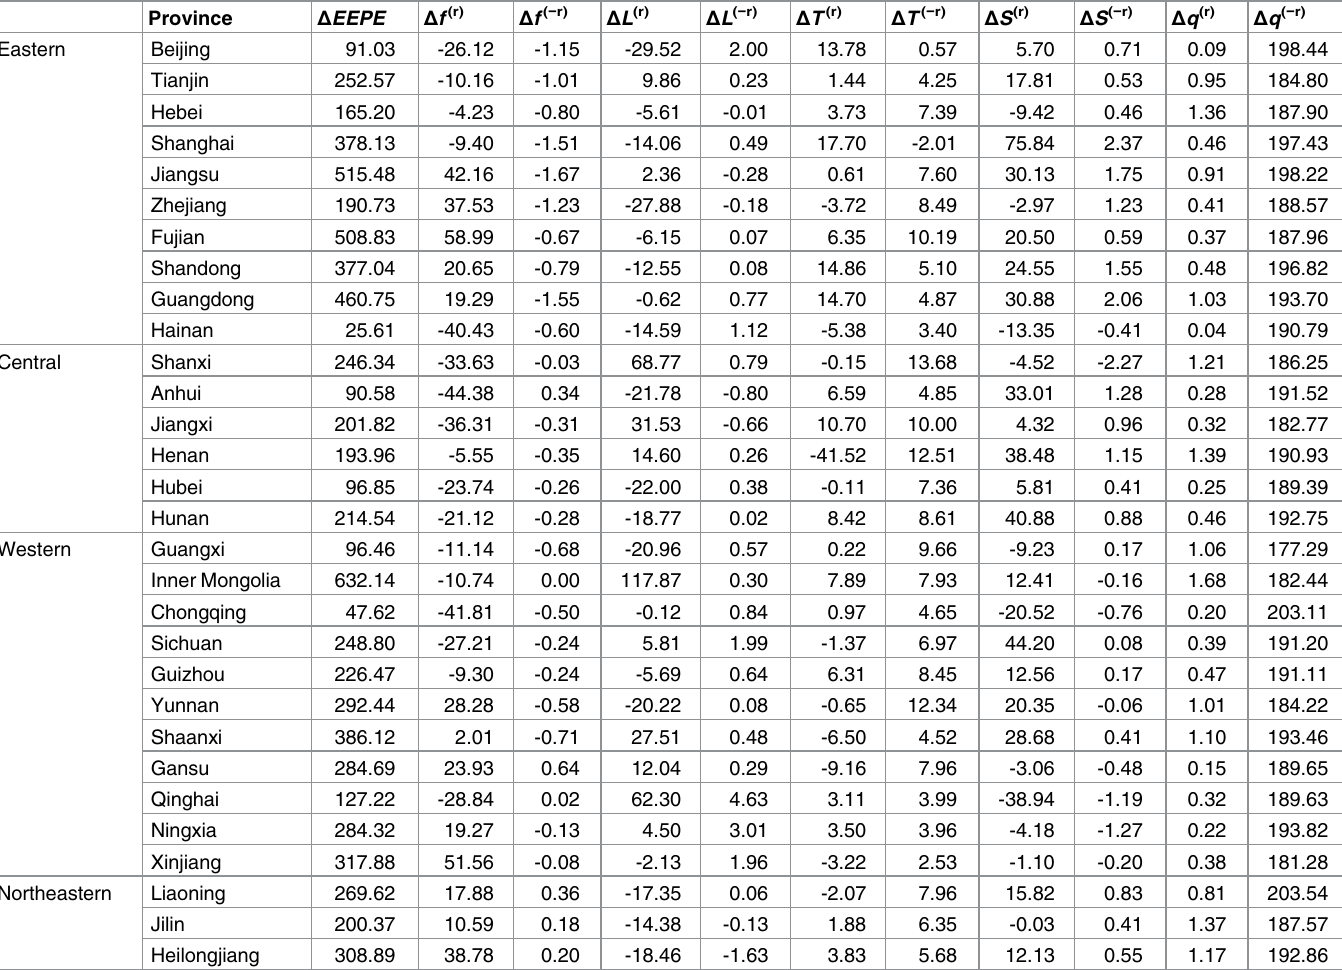
Table 2. Structure decomposition analysis of EEPE (2002–2010) (unit: